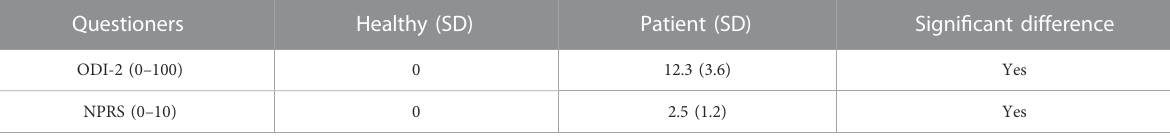
TABLE 3 Oswestry disabity inventory questionnaire and pain scale results from